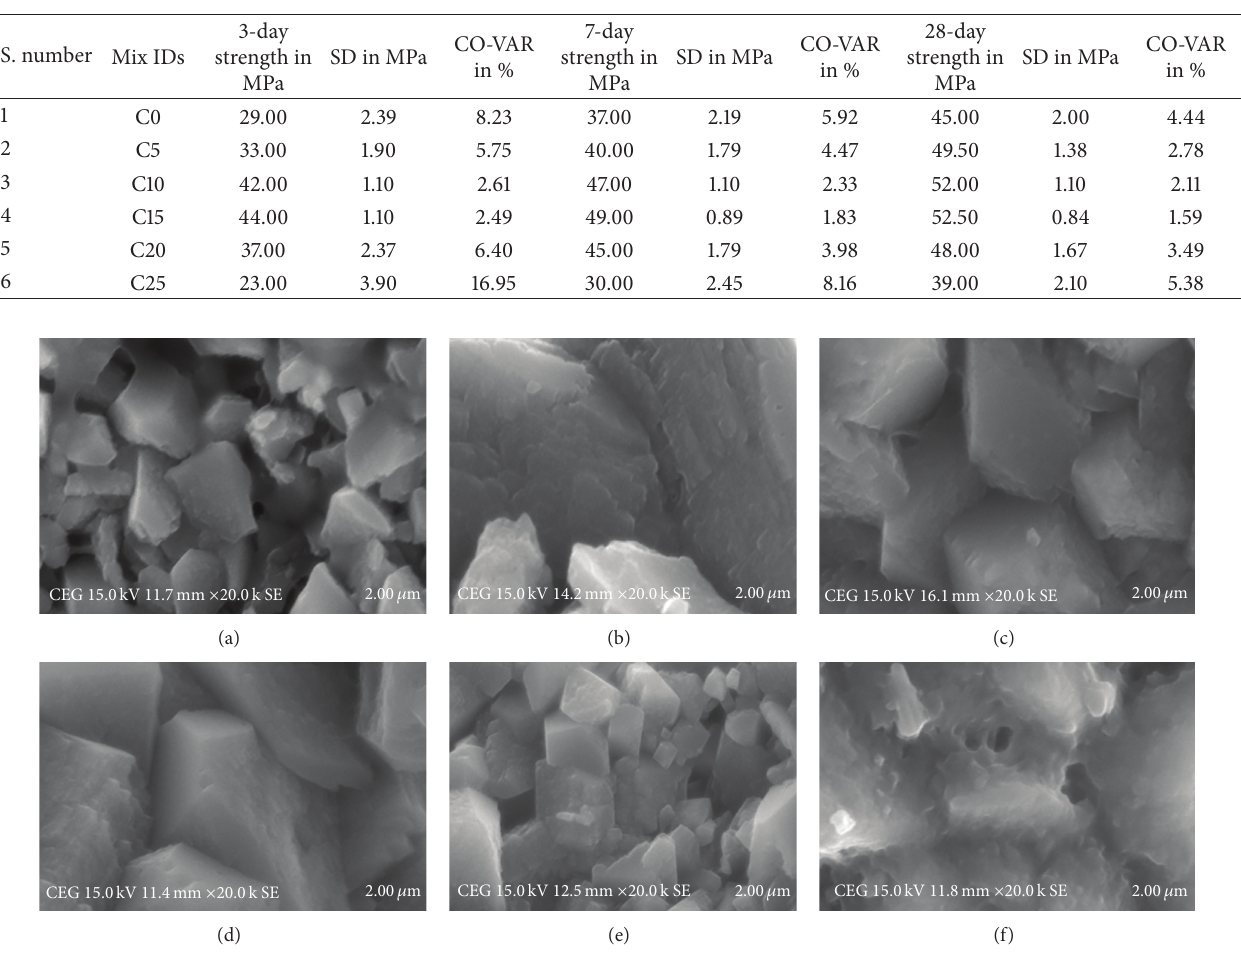
Table 3: Compressive strength of mortar cubes.